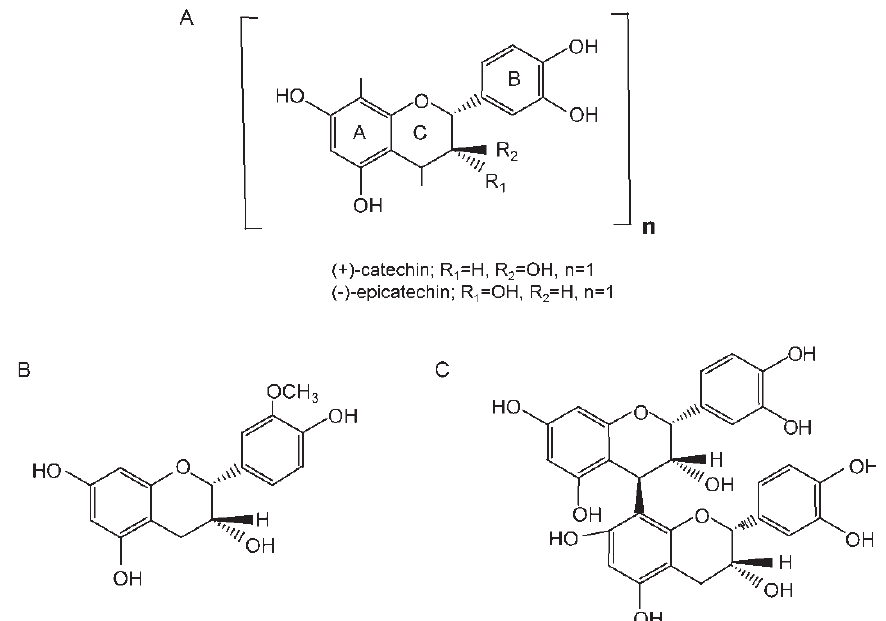
Figure 1. Chemical structures of (A) monomer and procyanidin oligomers, n ¼ 1 (monomer), 2 (dimer) to 10 (decamer); (B) 3 0 - O -methyl epicatechin; (C) Dimer B2 (epicatechin-(4 b .